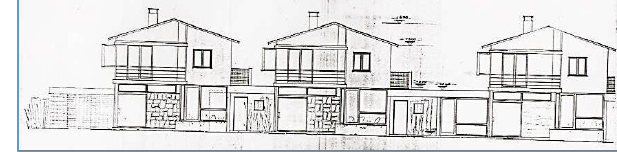
Figure 16. Facade of the buildings (Esentepe, 2013).